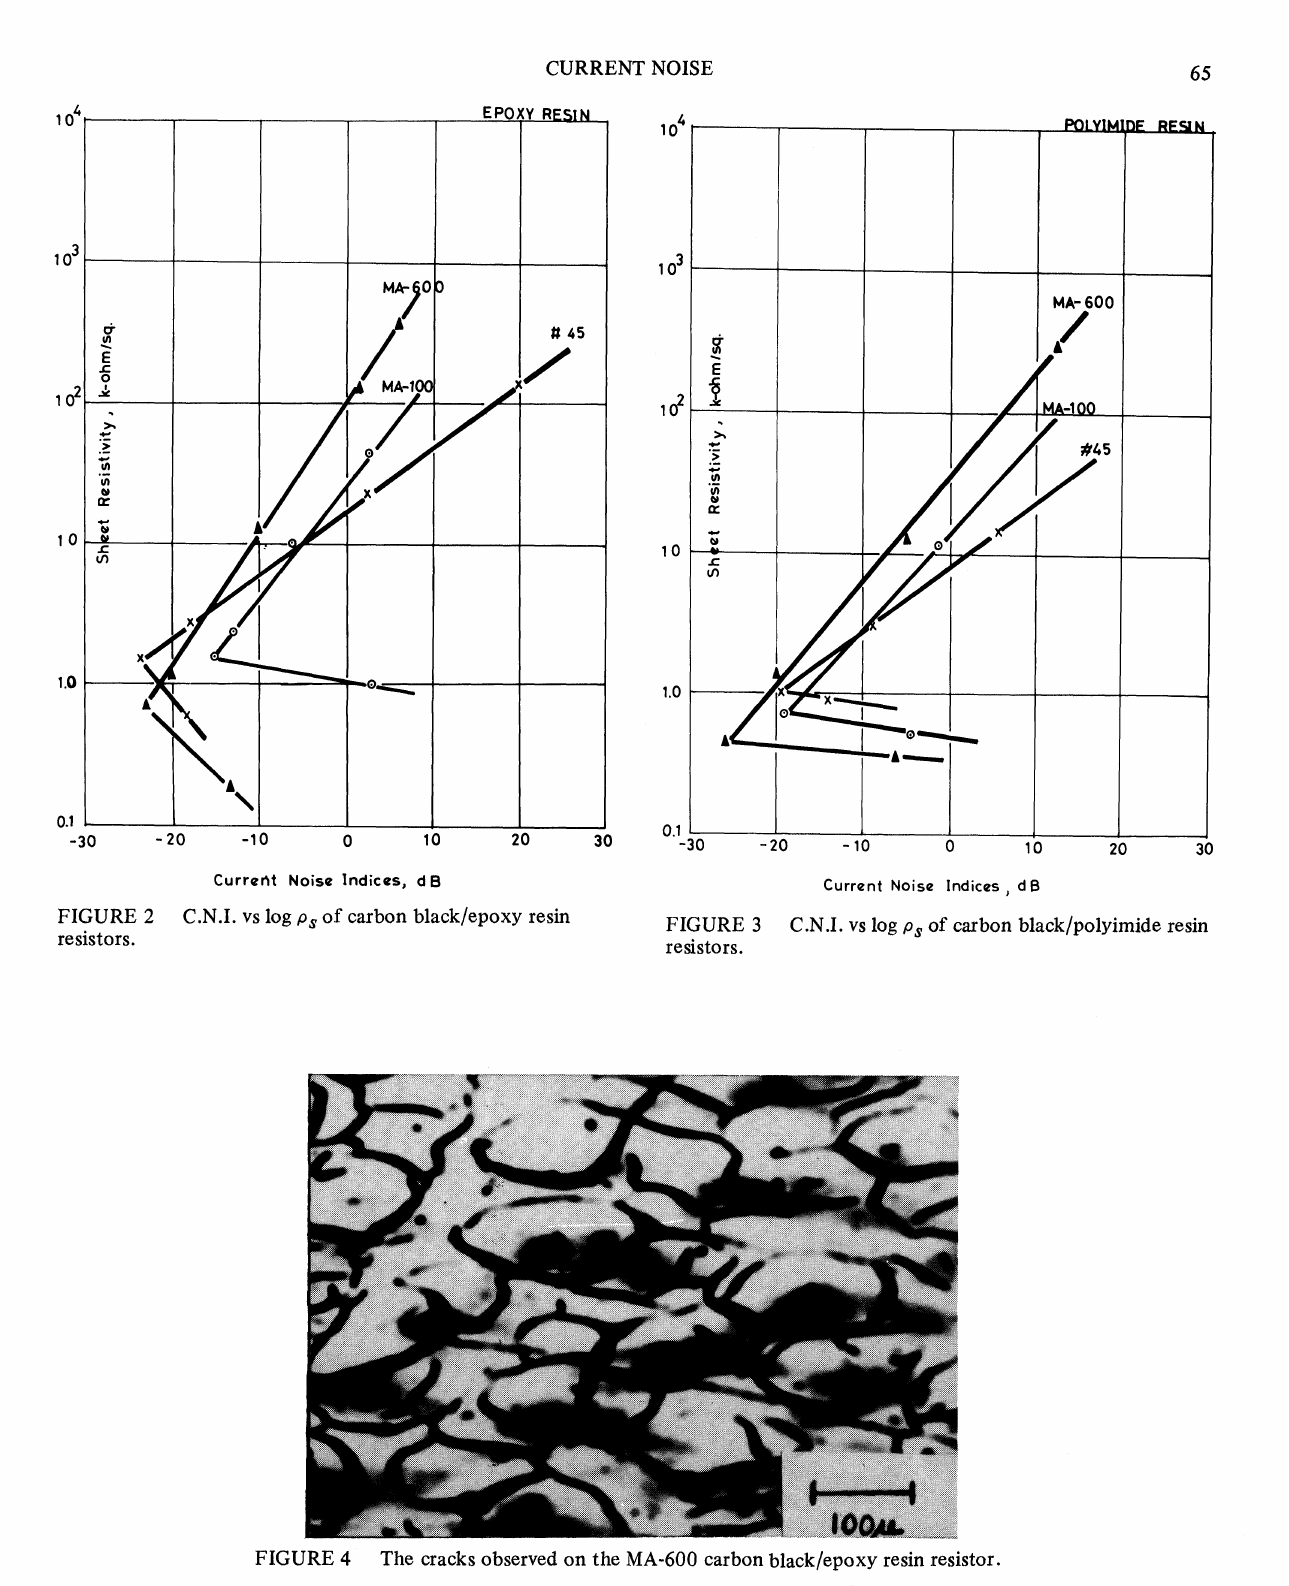
FIGURE 4 The cracks observed on the MA-600 carbon black/epoxy resin